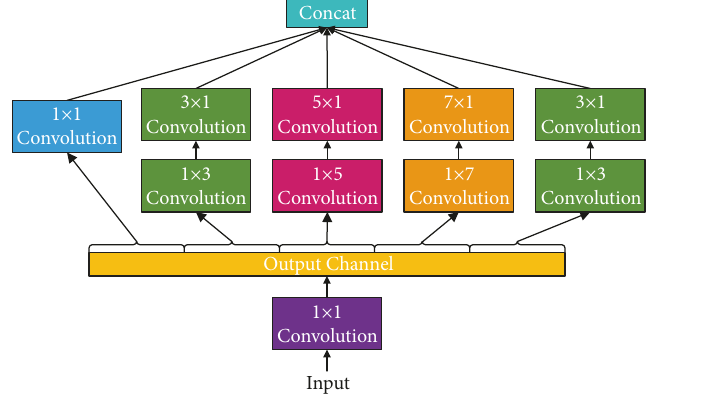
Figure 5: Xception